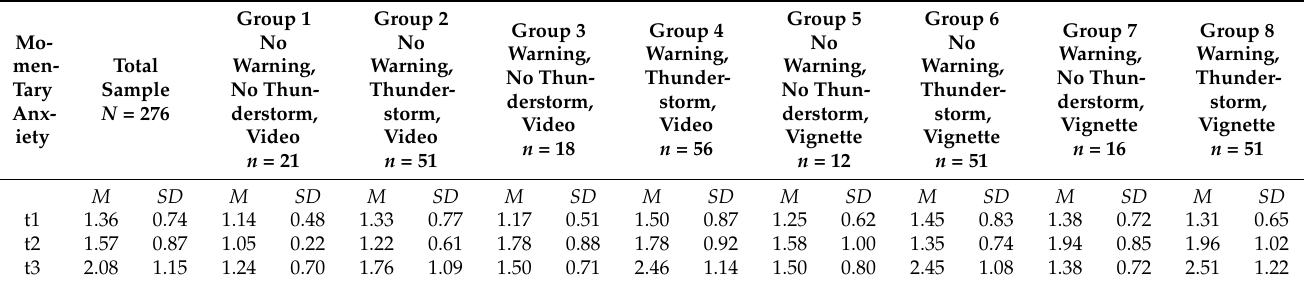
Table A1. Momentary anxiety in the overall sample, divided by groups (warning message vs. no warning message; thunderstorm vs. no thunderstorm; video vs.